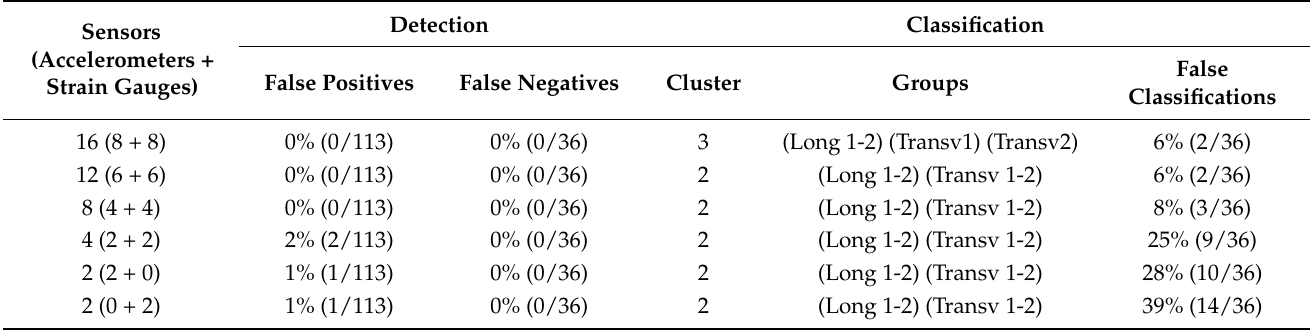
Table 3. False detection and classification relating to the number of